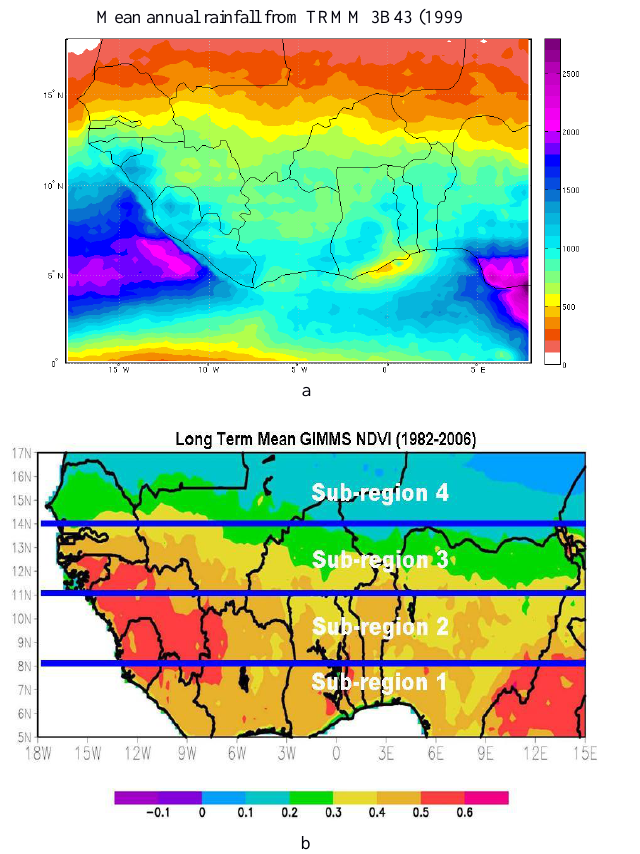
Figure 1. (a) Annual accumulated rainfall based on TRMM 3B43 data (1999–2006) and (b) mean normalized difference vegetation index (NDVI) over the regions. The boxes showing the subdivisions were made according to the climate division by Nicholson